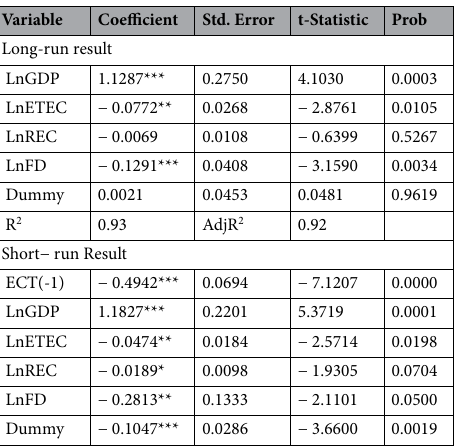
Table 6. ARDL results. ***P < 1%, **P < 5% and *P < 10%.